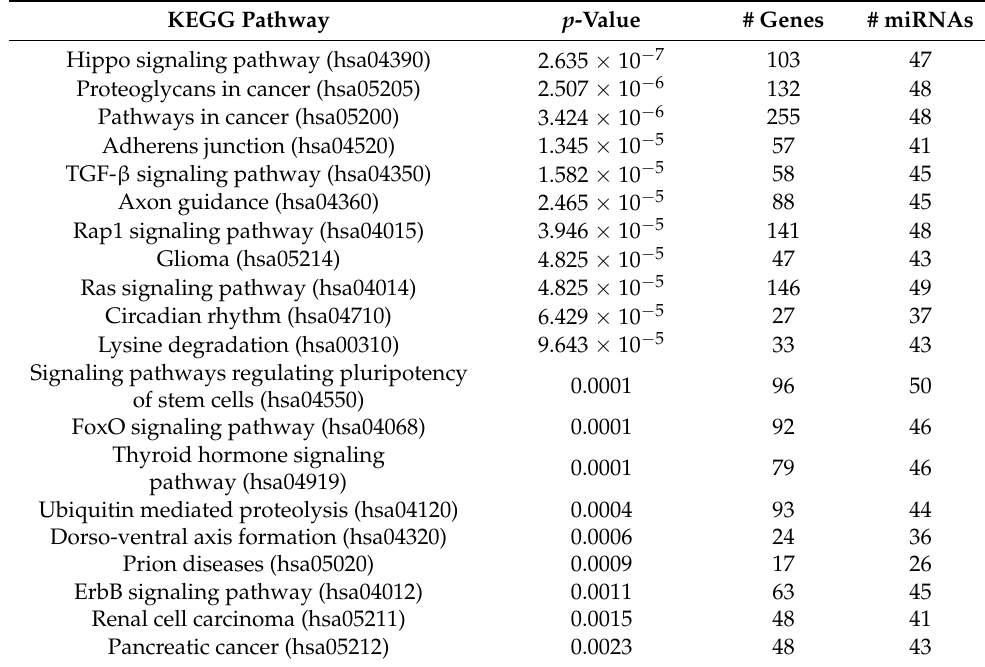
Table 3. Top 20 significant signaling pathway regulated by 14q32